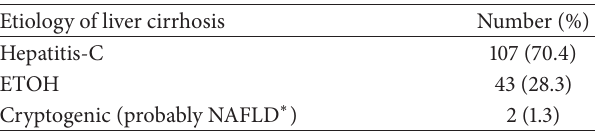
Table2:Distributionofetiologiesofcirrhosisamongstudysubjects.